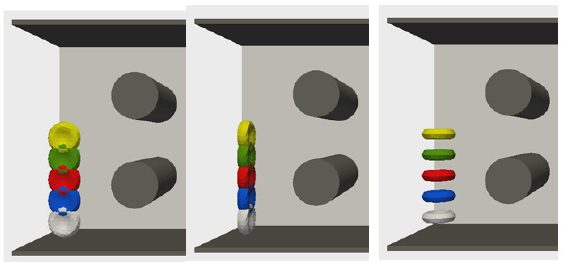
Fig. 2. Conjoint picture of RBCs in each starting position (from 5 to 25 μm) and each orientation (flat, cross and